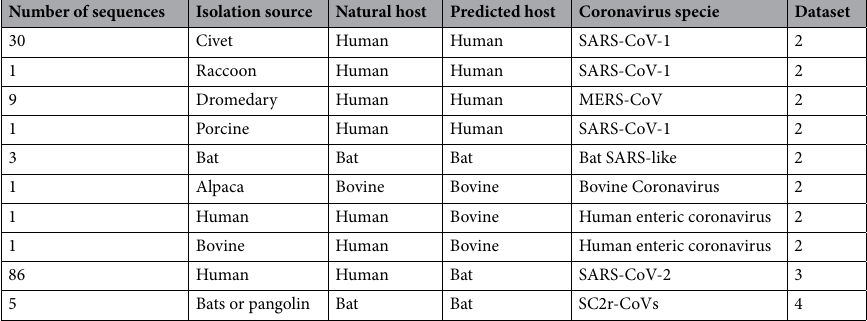
Table 1. Sequences used to the biological validation and prediction results for Datasets 2, 3 and 4.